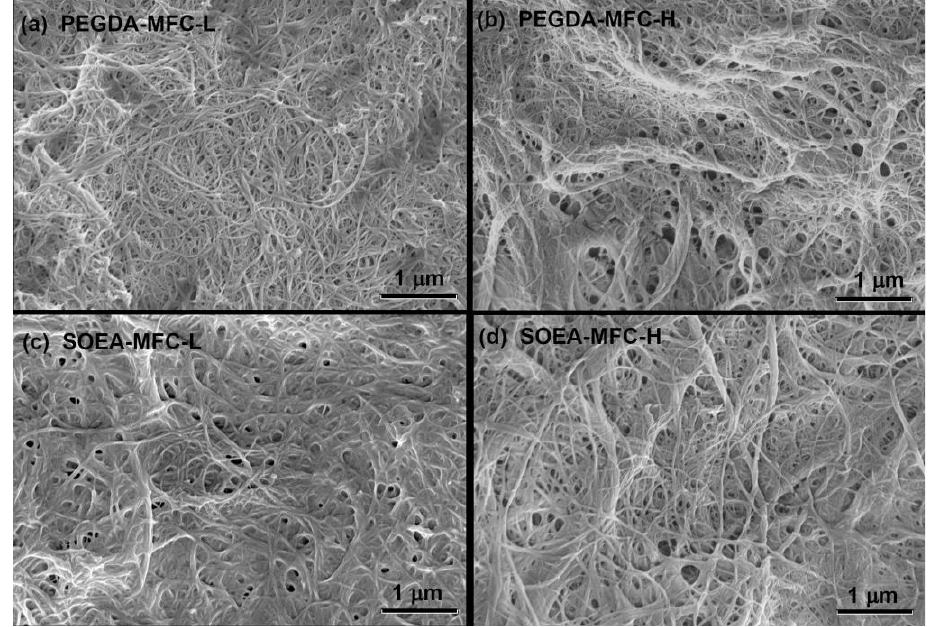
Figure 3. FESEM images of ( a ) PEGDA-MFC-L, ( b ) PEGDA-MFC-H, ( c ) SOEA-MFC-L, and ( d ) SOEA-MFC-H.